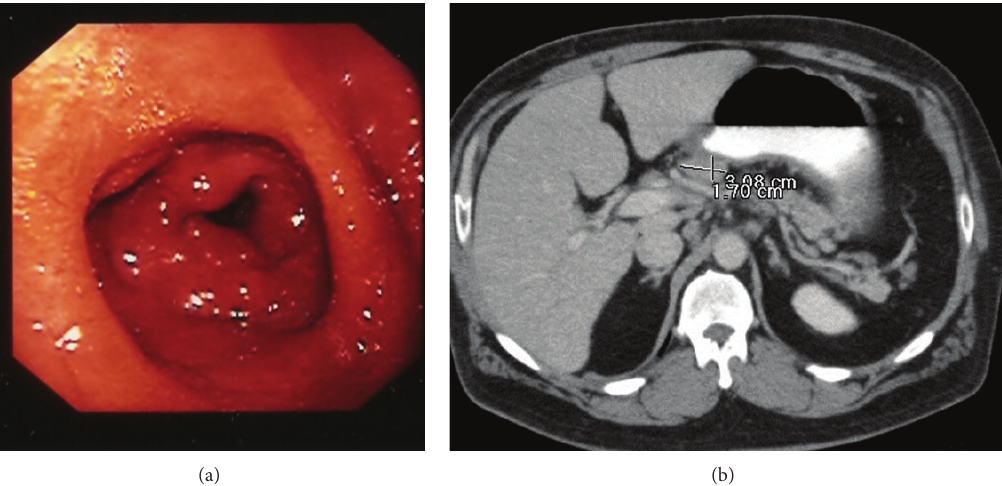
Figure 1: (a) Upper gastrointestinal endoscopy showing linitis plastic-like appearance and diffuse erythema. (b) Computer tomography showing the intra-abdominal adenopathy.